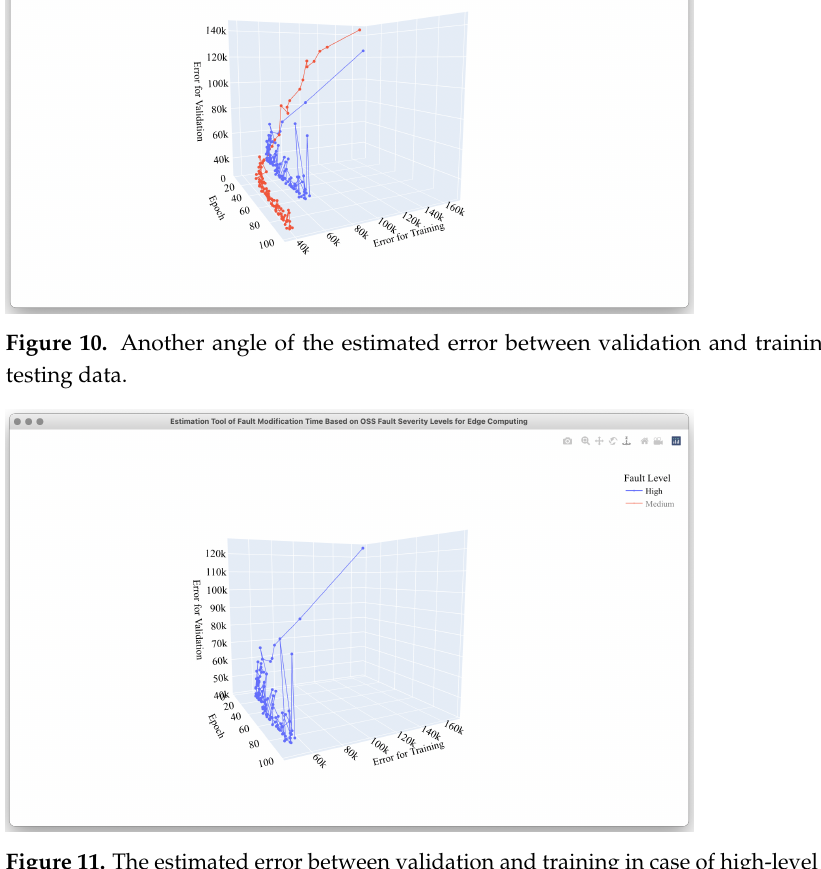
Figure 11. The estimated error between validation and training in case of high-level 30% testing